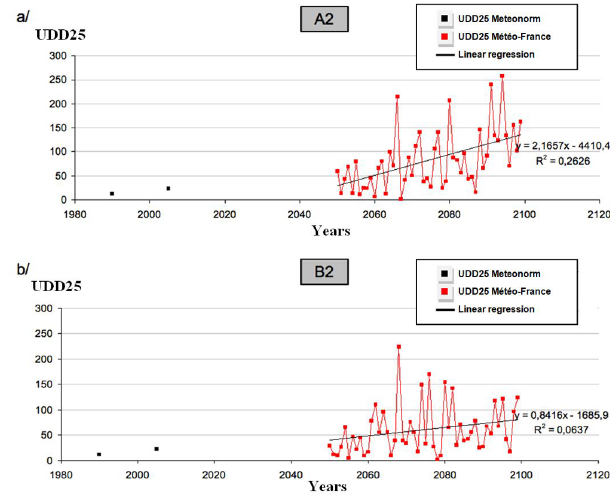
Fig. 6. Cooling UDD for the scenario A2 (a) and B2 (b) in